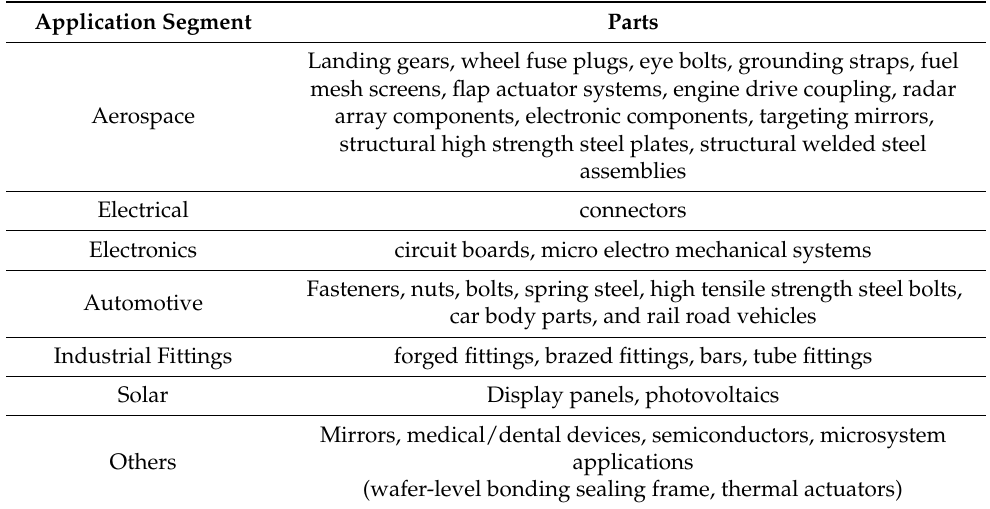
Table 1. Table showing the industrial applications of aluminum